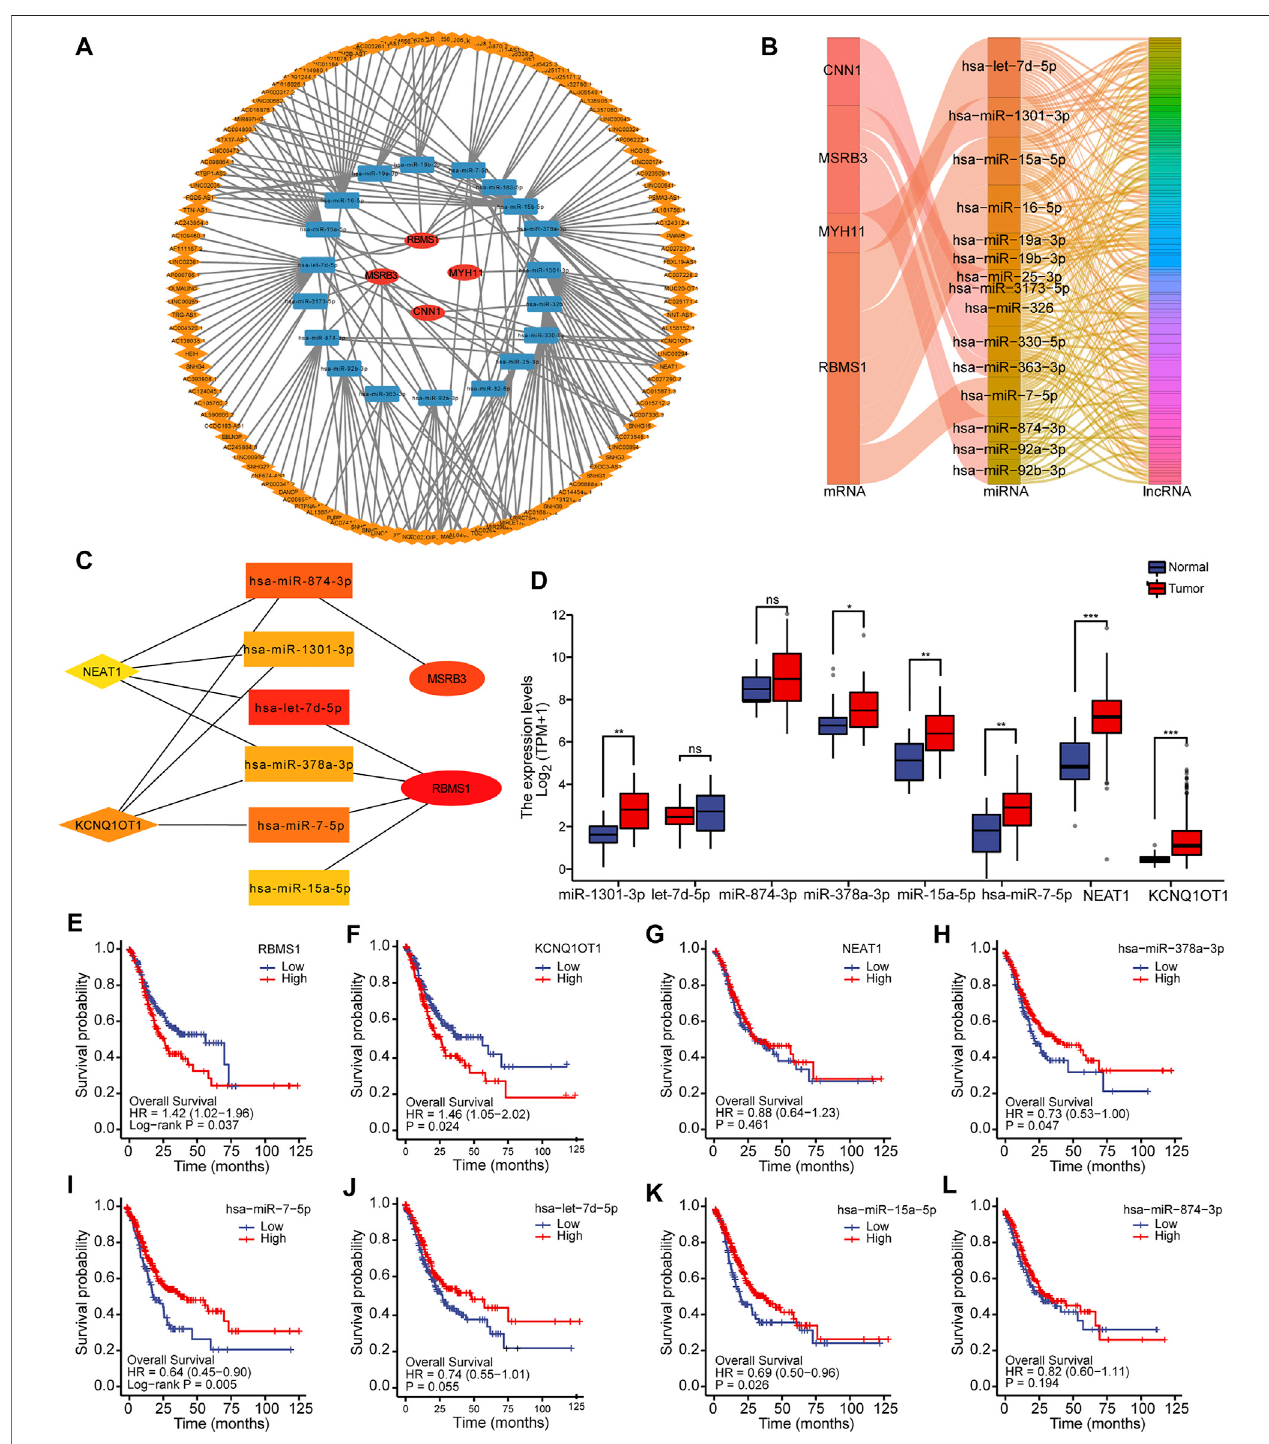
FIGURE 6 | Construction of the mRNA-miRNA-lncRNA regulatory network. (A) Construction of the ceRNA network associated with GC. (B) Sankey diagram for ceRNAnetworkvisualization. (C) Identi fi cationofthehubnetworkforfurtheranalysis. (D) BoxplotsshowingtheexpressionlevelsofmiRNAsandlncRNAsinhubgenes. (E – L) Kaplan-Meier curves showing the overall survival based on the top hub genes.